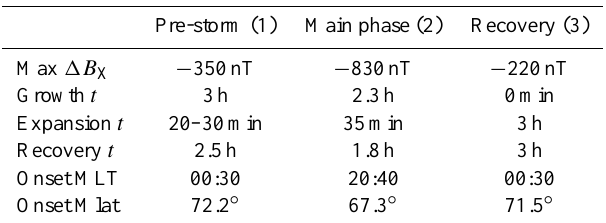
Table 1. Summary of substorms 1, 2 and